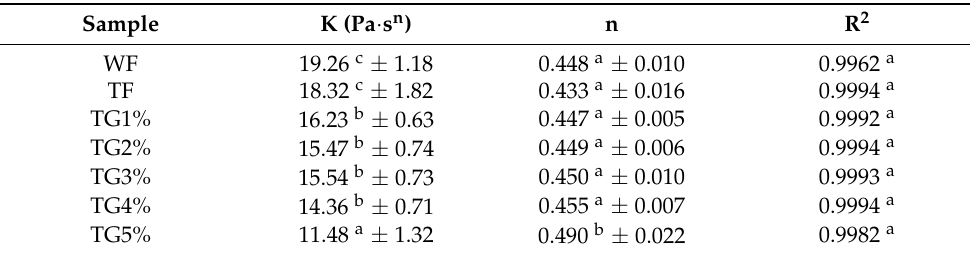
Figure 2. Viscosity curves of example samples. Table 4. Parameters of power law model describing the flow curves of the wheat flour, triticale flour and triticale flour with vital